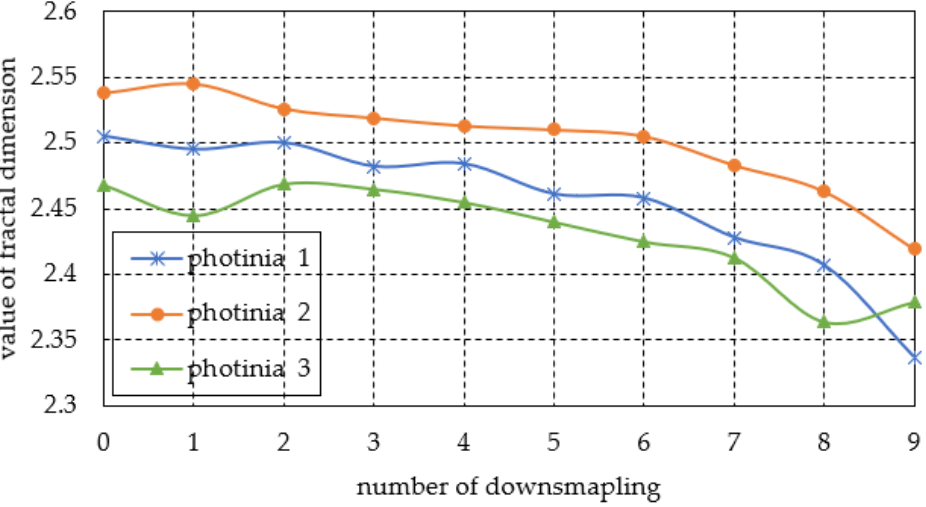
Figure 9. Trend of the fractal dimension with point cloud down sampling of photinia trees 1 to 3. The photinia tree is more complex than the ginkgo tree since its trunk begins to have multiple main branches near the ground, which makes it have a sudden change in the numerical calculation and precision of the fractal dimension. As the number of point clouds decreases, low-density point clouds are not sufficient to accurately describe the complex three-dimensional structure of the heather tree, but it can be stable in a certain range when the number of point clouds is sufficient. When the number of point clouds is too small, the number of point clouds contained in the non-empty box is too small during the space division process, so that the number of non-empty boxes is related to the number of point clouds, and the number of samples used to fit the line is also reducing, so that the fractal dimension accuracy is